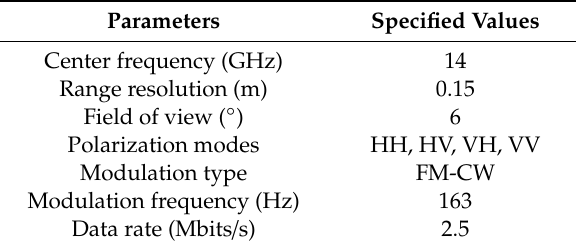
Table 2. Main parameters of Tomoradar. FM-CW: Frequency Modulated Continuous